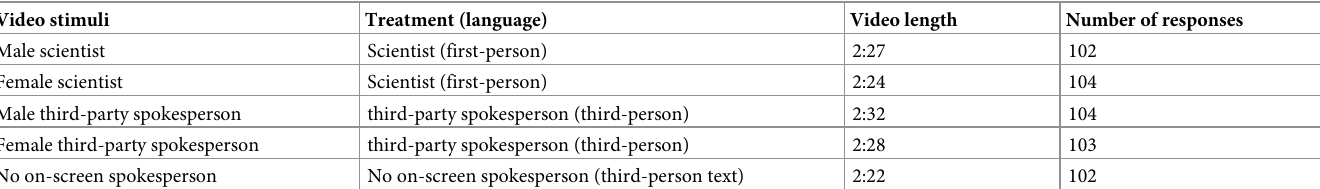
Table 1. Summary of video stimuli, treatment, video length, and number of complete